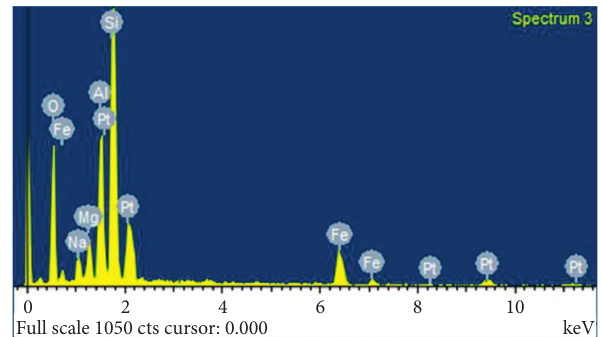
Figure 6: The result of microdomain